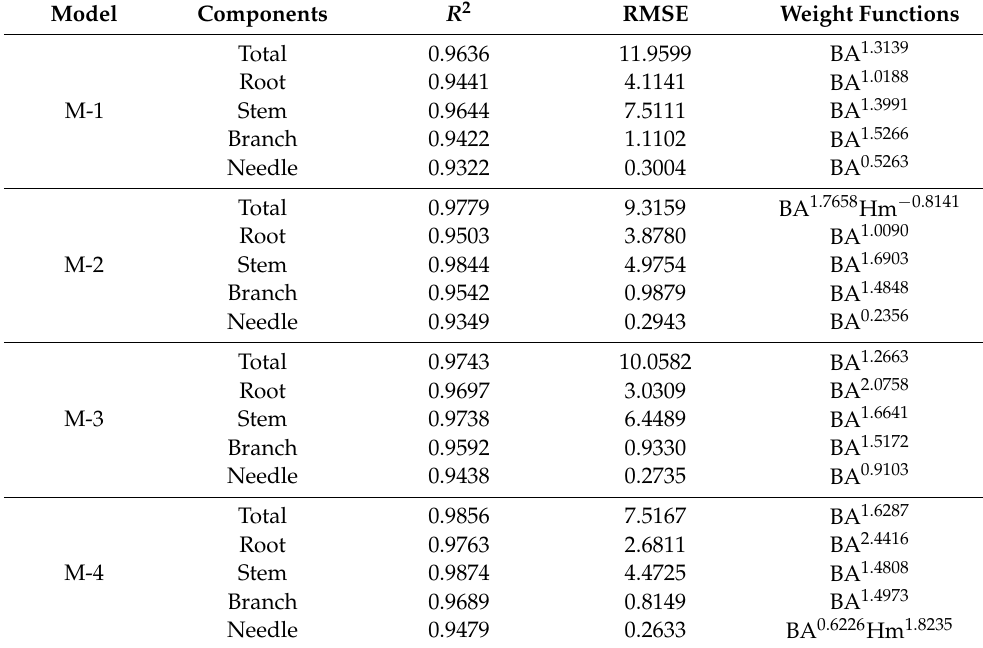
Table 3. The goodness-of-fit statistics and weight functions of the stand-level biomass models. Model